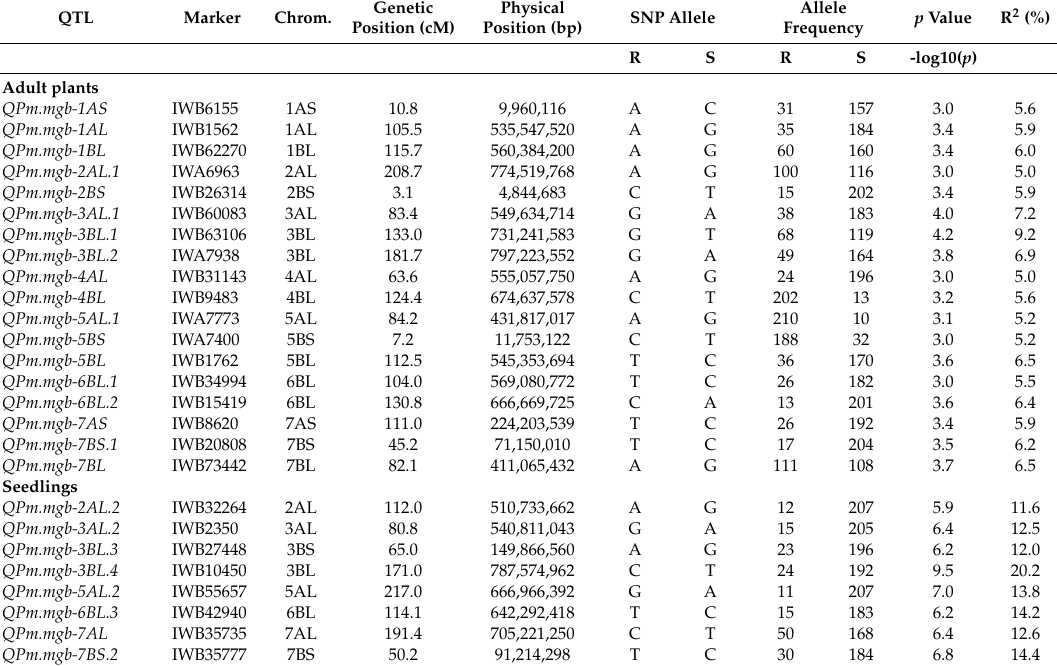
Table 2. Quantitative trait loci (QTL) for adult plant resistance and seedling (isolate O2) resistance to Blumeria graminis f. sp. tritici in a tetraploid wheat collection. Marker position is referred to the durum wheat consensus map [42] and physical position to the genome assembly of Triticum turgidum ssp. durum cv. Svevo.v1